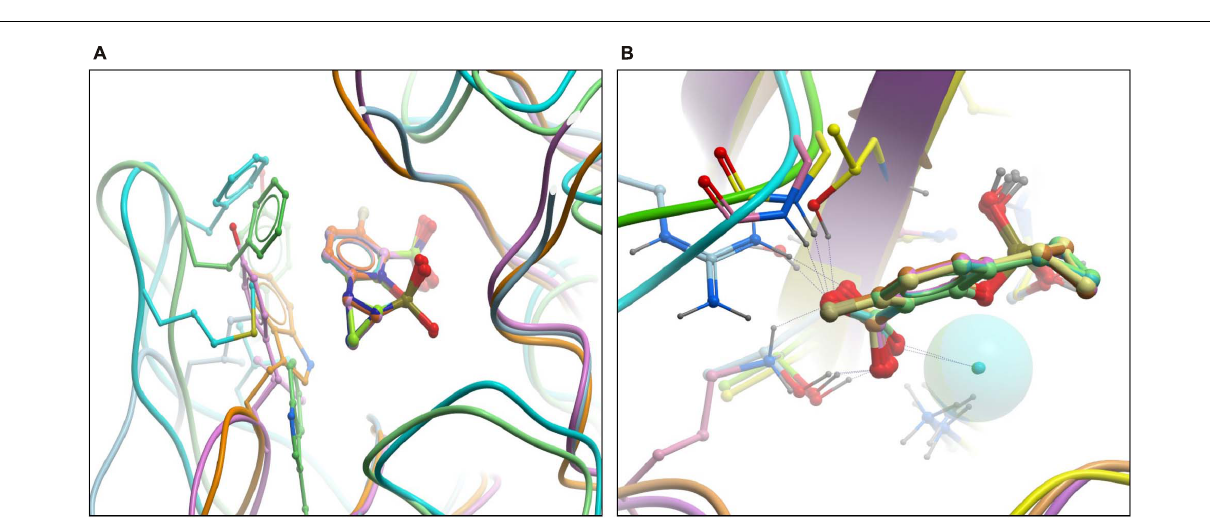
FIGURE 3 | High resolution structures of RPX7728 with multiple enzymes: superimposition of β -lactamases using the ligand. (A) The aromatic/lipophilic interactions are shown. (B) Close-up of carboxylate interactions and